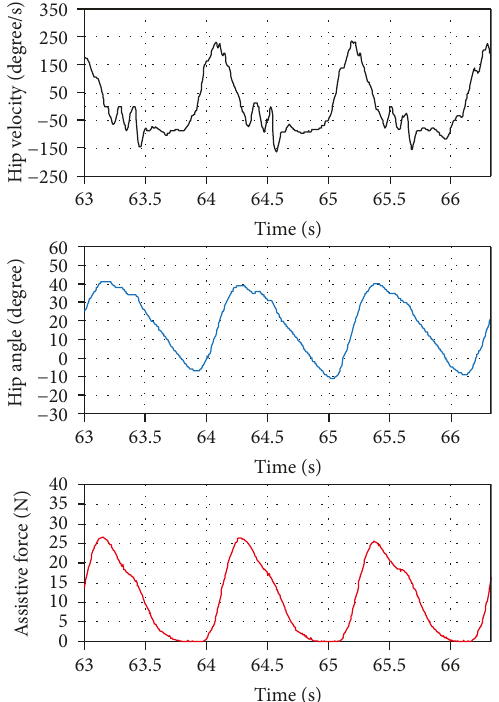
Figure 4: Typical data of hip angular velocity, hip angle, and assistive force.